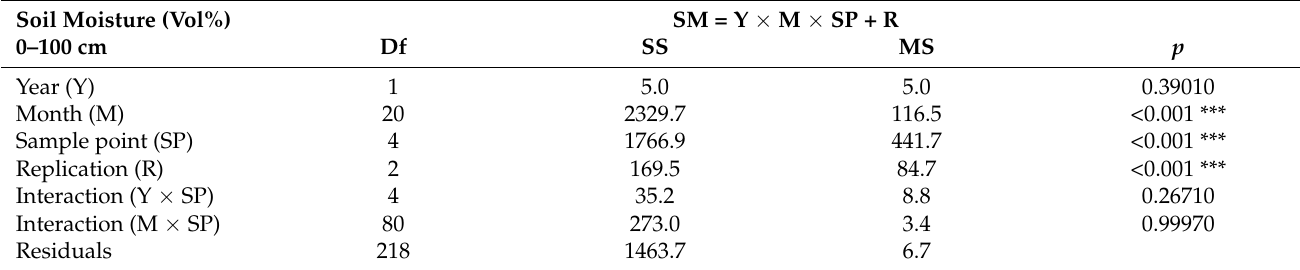
Table 1. Analysis of variance for soil moisture 0–100 cm depth. ***, **, *: significant at p -value ≤ 0.001, ≤ 0.01, ≤ 0.05, respectively. Abbreviations: Df: degree of freedom; SS: sum of square; MS: mean square.